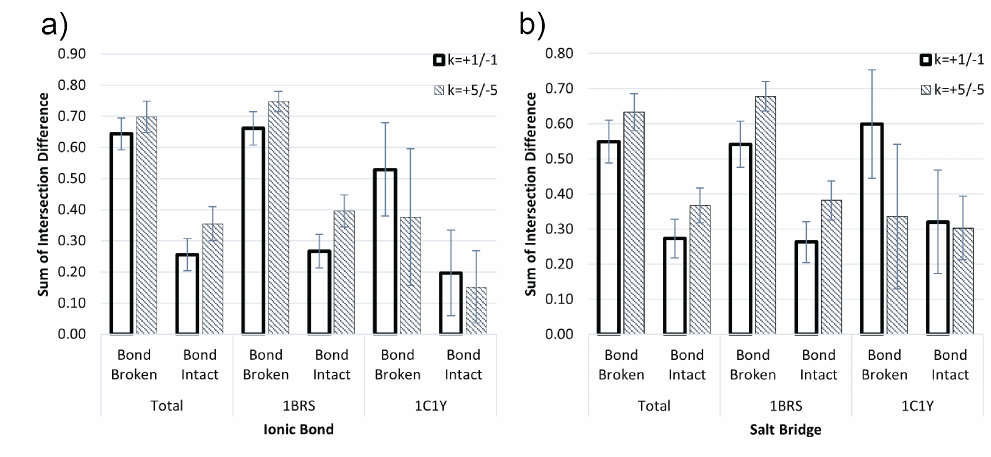
Figure 5. Comparison of interface intersection volume changes when a bond is broken and when a bond remains intact for ( a ) Ionic bonds and ( b ) Salt Bridges. Each bond compared using volumes calculated from VASP-E for Barnase-Barstar (1BRS) and Rap1a-raf